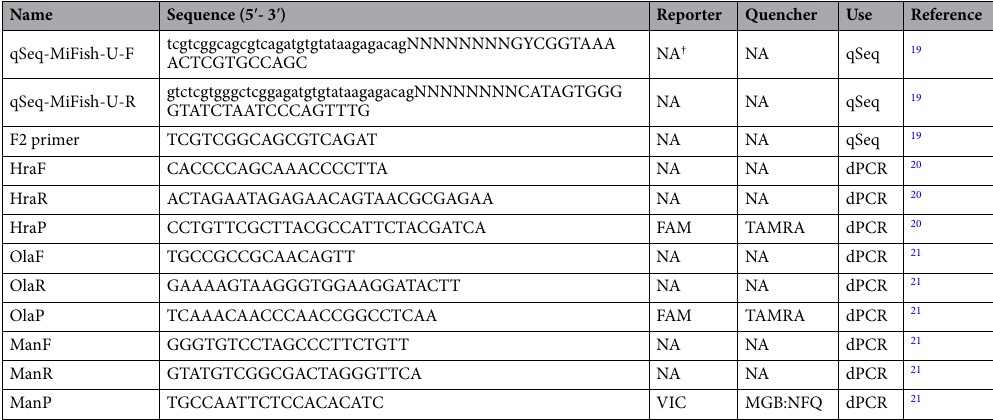
Table 1. Oligonucleotide sequences used in this study. Small case letters in sequences indicate regions for index PCR. † Not